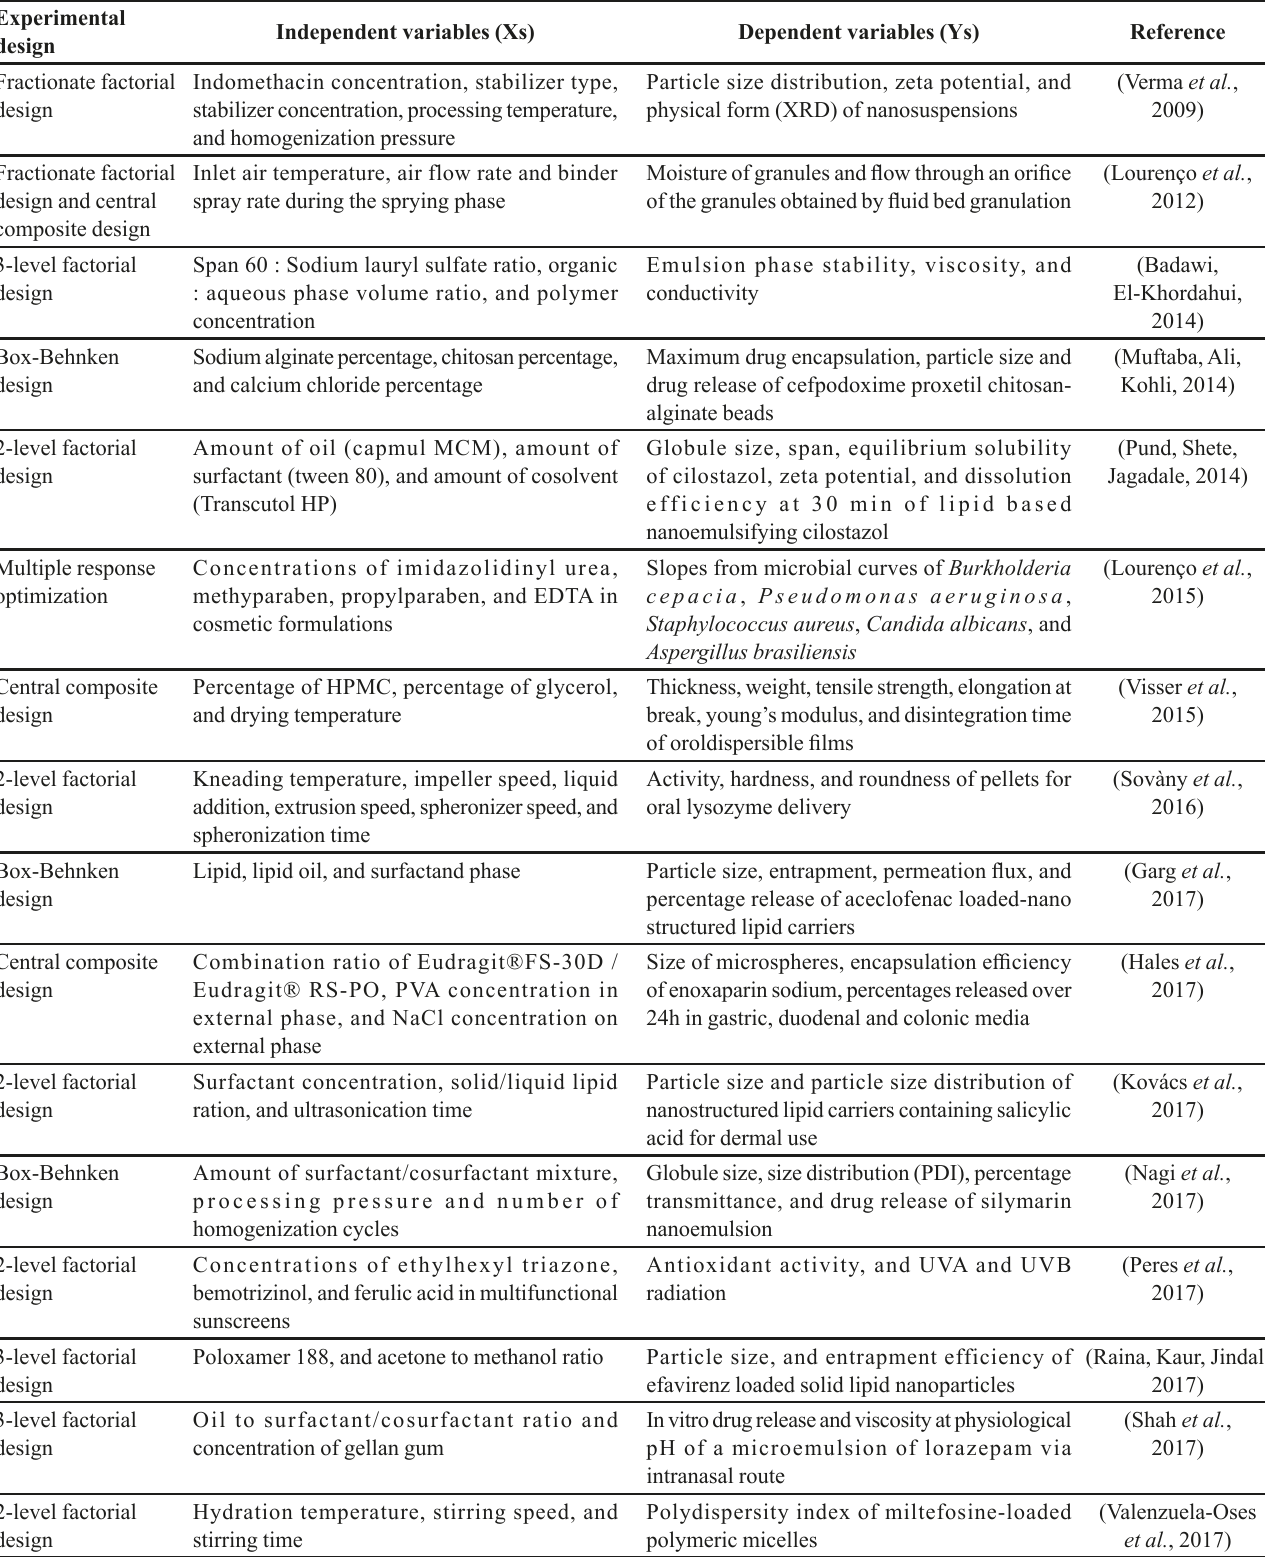
TABLE VII – Examples of DoE applications for pharmaceutical development, experimental design adopted, independent variables (input factors – Xs), and dependent variables (output responses –